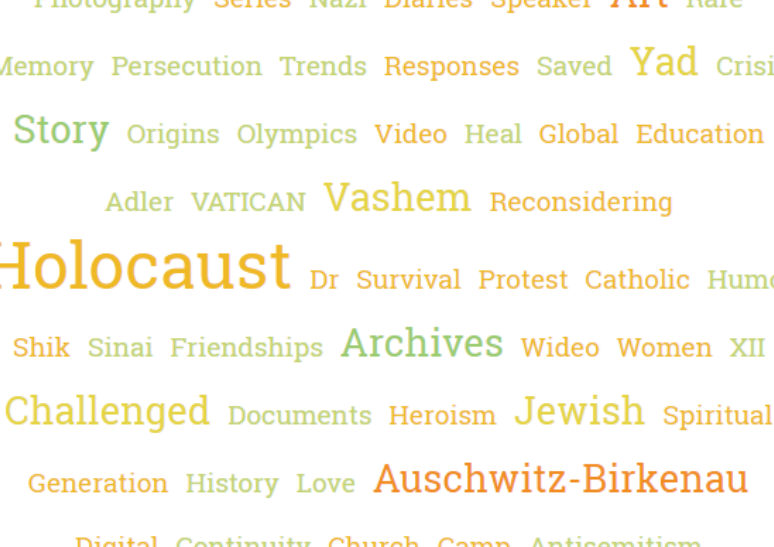
Figure 4. Words that the museums used most frequently words on YouTube (relative frequency is expressed both by text size and by colour).